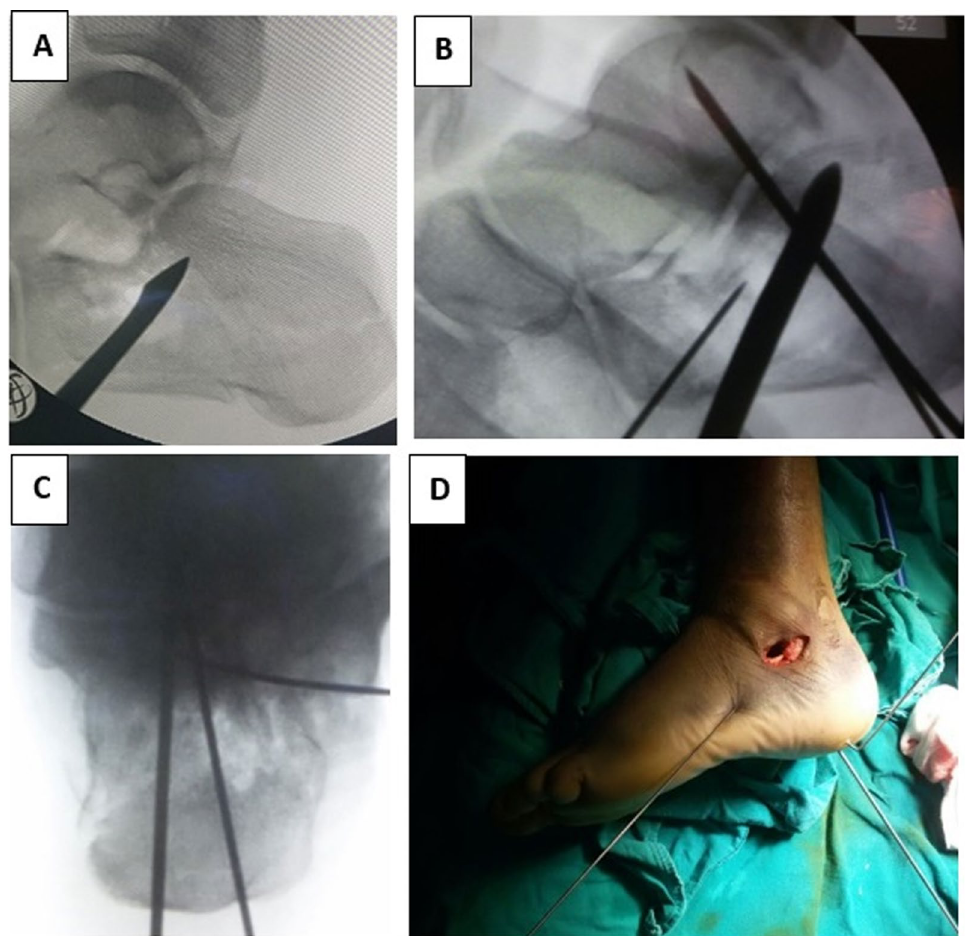
Fig. 2 Intraoperative images. A Image clarifying the elevation of the depressed articular fragment using a bone elevator. B , C Lateral and axial fluoroscopic images, respectively, for evaluating the reduction. D Clinical image showing the minimally invasive sinus tarsi